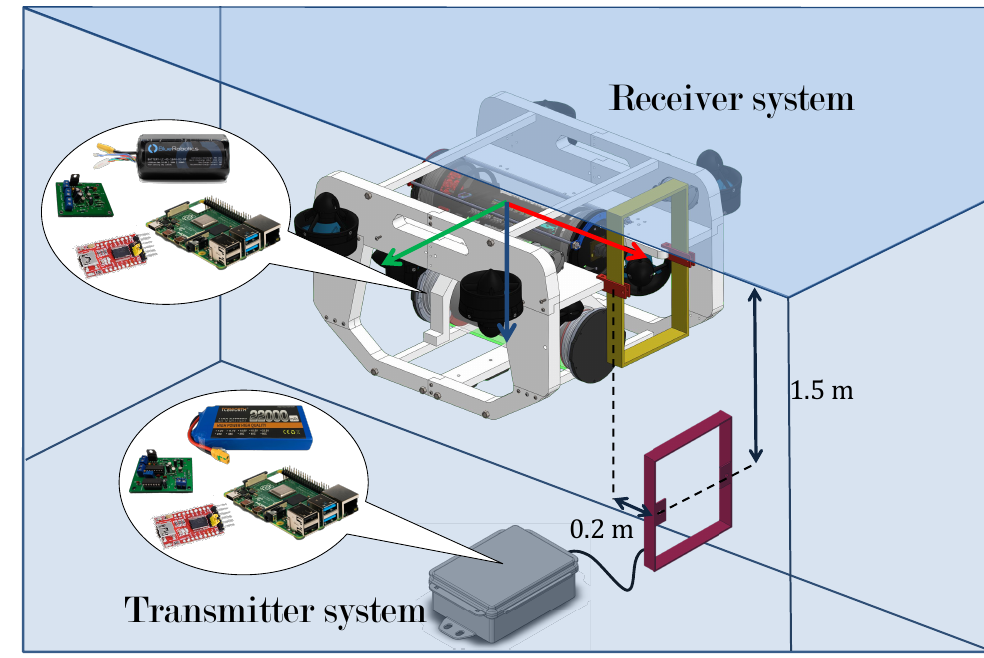
Figure 11. Experimental test system.